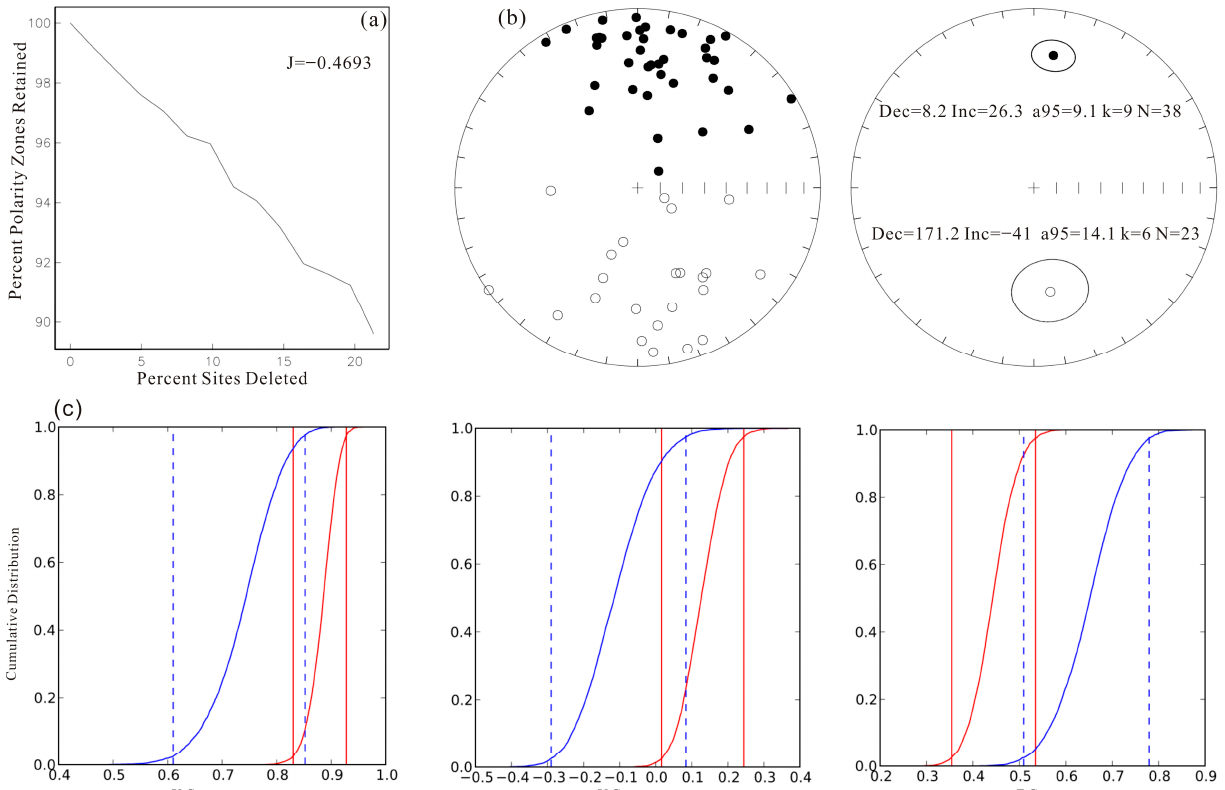
Figure 7. Paleomagnetic field tests of the results for the TTH-D section. ( a ) Jackknife test for the studied section. ( b ) Equal-area stereographic projection with the accepted ChRM directions after tilt correction. Solid/open circles represent downward/upward inclinations. ( c ) Bootstrap reversal test of the section and the overlap of 95% confidence intervals for the X, Y, and Z components, indicating a positive reversal test.